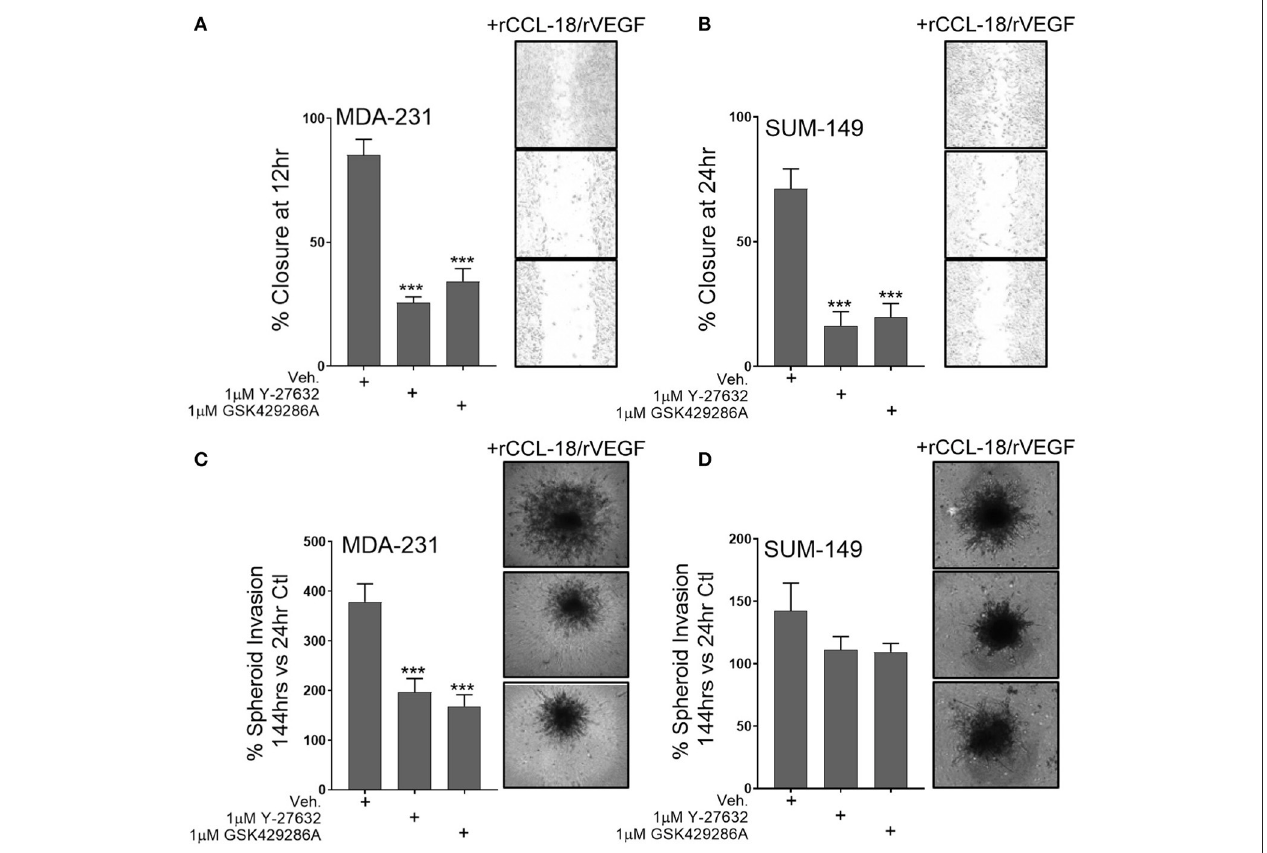
FIGURE 5 | ROCK inhibition significantly diminishes synergistic VEGF/CCL-18 included breast cancer cell migration and invasion. (A) Wound closure rates are dramatically slowed in MDA-231 cells pretreated with either 1 µ M Y-27632 or 1 µ M GSK429286A followed by VEGF and CCL-18 administration. (B) Wound closure rates in SUM-149 cells are slowed following pretreatment with the ROCK inhibitors, Y-27632 or GSK429286A followed by rVEGF/CCL-18 administration. (C) Results from spheroid invasion assays display VEGF/CCL-18-mediated invasion is reduced in MDA-231 cells pretreated with either ROCK inhibitor. (D) ROCK inhibition in SUM-149 cells does not significantly inhibit cellular invasion. Data is reported as an average ± std. dev. of at least 3 independent experiments, analyzed by one-way ANOVA, *** p >